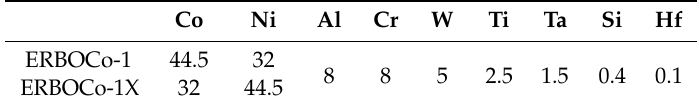
Table 1. Nominal composition of alloys ERBOCo-1 and ERBOCo-1X in at.%. Co Ni Al Cr W Ti